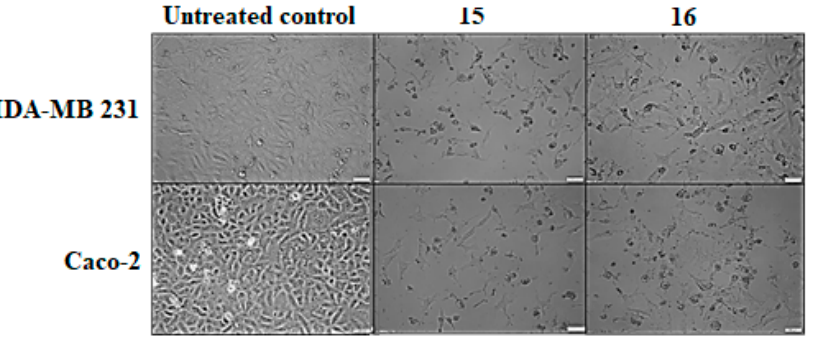
Figure 2. Morphological changes of MDA-MB 231 and Caco-2 cells after 72 h treatment with 15 and 16 at 3 µM.